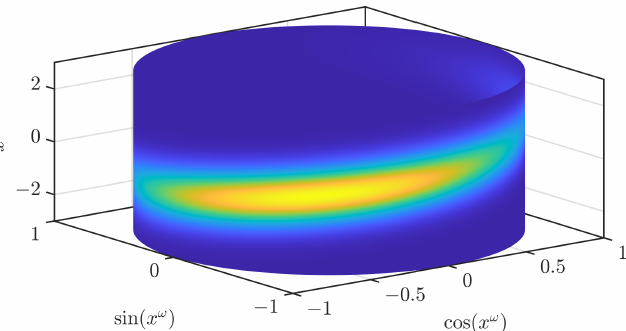
Figure 1. True density of the partially wrapped normal distribution.